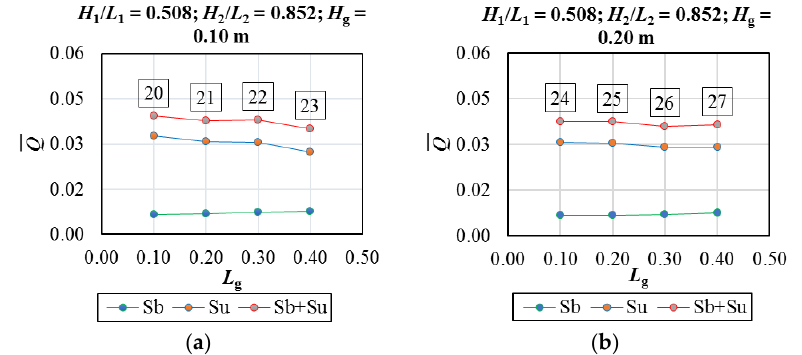
Figure 20. Behavior of Q ̅ × L g for: ( a ) cases 20, 21, 22 and 23 and ( b ) 24, 25, 26 and 27.